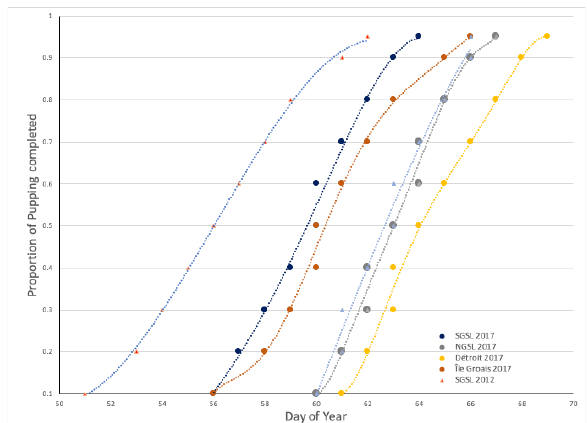
Figure 6. Proportion of pups born versus day of year in the four whelping concentrations in 2017 (circles), and three concentrations in 2012